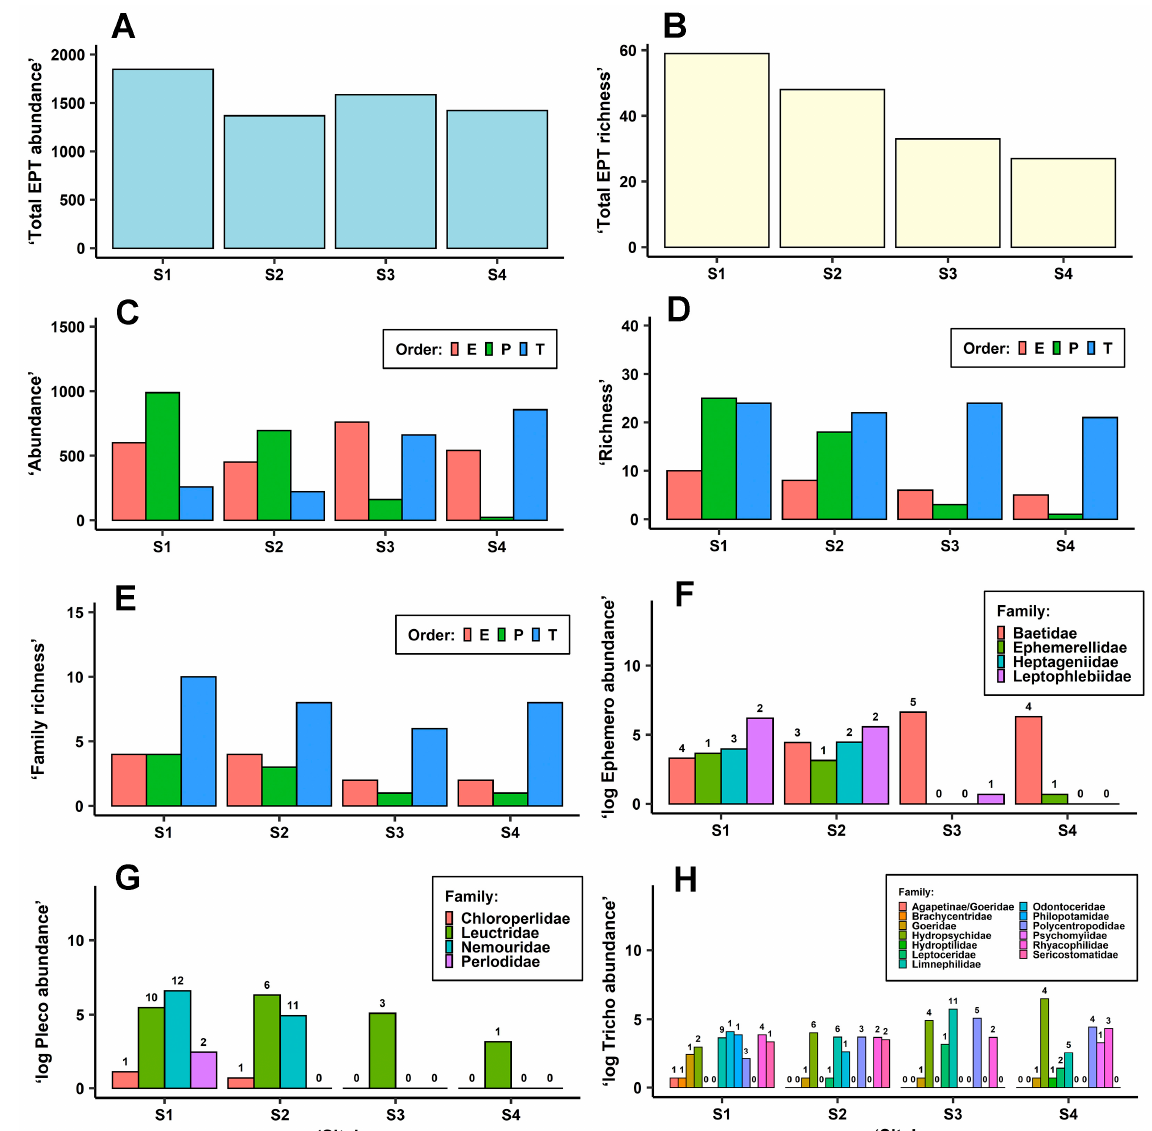
Figure 2. Bar graphs visualising ( A , C ) ‘abundance’ (number of individuals), ( B , D ) ‘richness’ (number of taxa), ( E ) ‘family richness’ (number of families), and ( F – H ) abundances and richness of individual detected families of Ephemeroptera, Plecoptera, and Trichoptera, respectively, summarised for each ‘site’ from the samples taken at all sampling times. Values in the bar graphs ( F – H ) are transformed by a natural logarithm, and the ‘richness’ is displayed above each column. E—Ephemeroptera, P—Plecoptera, T—Trichoptera.